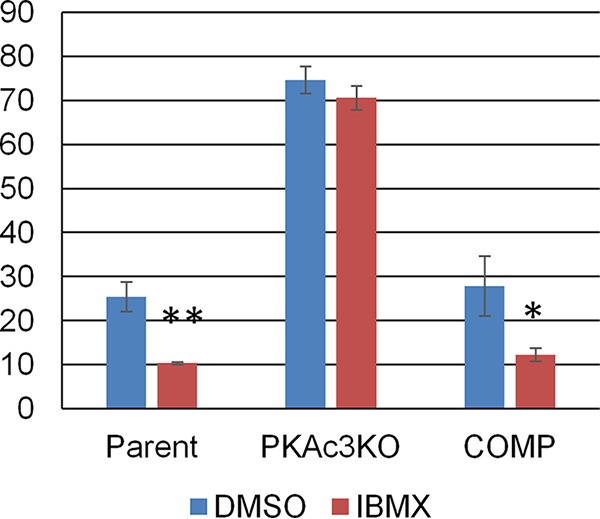
Long-term elevation of cAMP causes tachyzoite maintenance via TgPKAc3 signal. After a 2-h invasion window, parasites were treated with IBMX (500 µM final concentration) or vehicle control DMSO for 48 h. The cyst wall was stained to measure the bradyzoite differentiation status in the parental parasite PruΔku80Δhxgprt (Parent), knockout clone PruΔku80Δpkac3 (PKAc3KO), and complemented clone PruΔku80Δpkac3::PKAc3-3HA (COMP). Cyst wall-positive vacuoles were identified as parasitophorous vacuoles that have anti-CST1 signal associated with the parasitophorous vacuole as shown in Fig. 5A. At least 100 total vacuoles per sample were counted, and percentages of cyst wall-positive vacuoles per total vacuoles are shown. Mean values and standard deviations from independent triplicate experiments are shown. Student’s t test between DMSO and IBMX treatment was performed. *, P < 0.05; **, P < 0.01.